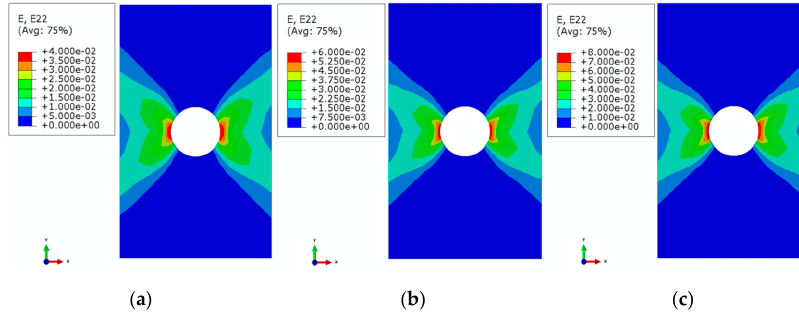
Figure 12. Simulated strain fields in the ( a ) 1st cycle, ( b ) 10th cycle and ( c ) 20th cycle.